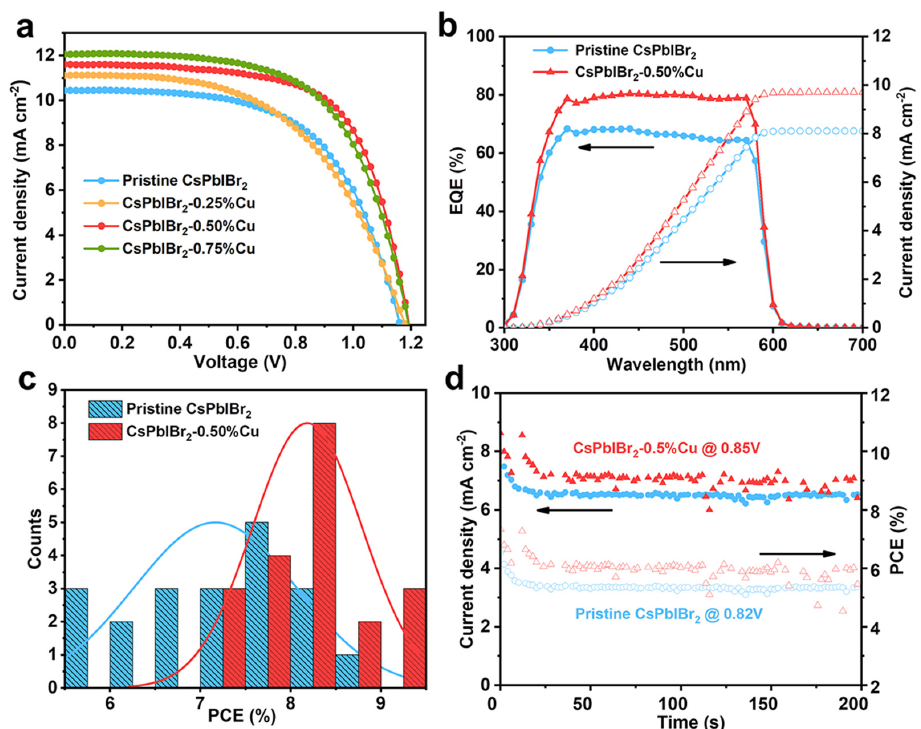
Figure 1. ( a ) J − V curves of CsPbIBr 2 and various Cu + -doped CsPbIBr 2 cells under a reverse scan direction. ( b ) EQE profiles, integrated photocurrent densities based on CsPbIBr 2 and CsPbIBr 2 -0.50%Cu devices, ( c ) statistical PCE distributions of PSCs based on CsPbIBr 2 and CsPbIBr 2 -0.50%Cu, ( d ) steady PCE and J sc values of CsPbIBr 2 and CsPbIBr 2 -0.50%Cu cells.